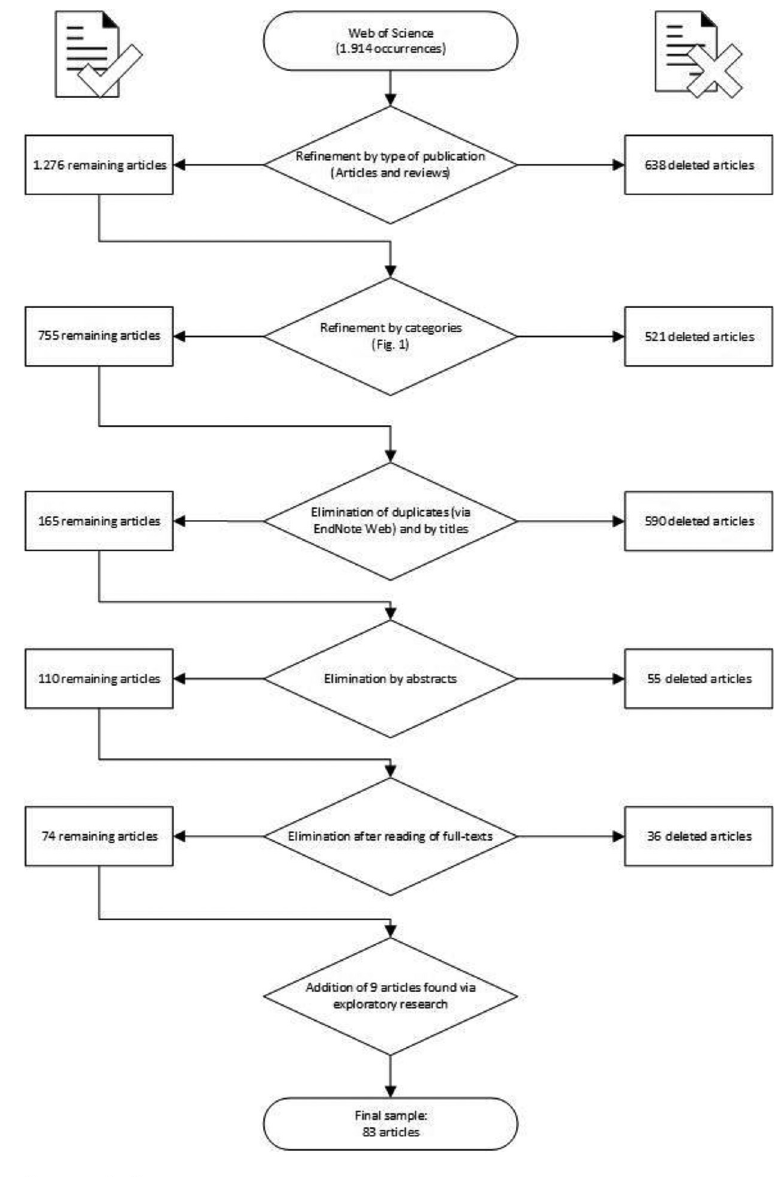
Figure 2. Filtering